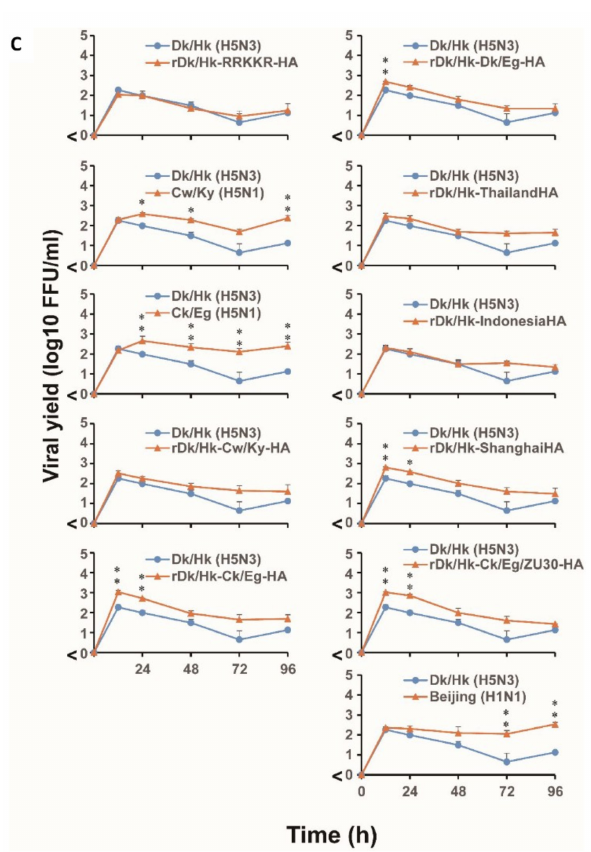
Figure 7. Growth kinetics of avian influenza viruses and their recombinant viruses in primary human tracheal epithelial cells and their established clones. ( A ) HTEpCs were infected with H5N1 (Cw / Ky (H5N1) and Ck / Eg (H5N1)), Dk / Hk (H5N3), rDk / Hk-RRKKR-HA, and recombinant H5N3 containing the HA gene from H5N1 viruses (as described in Figure 5) at an m.o.i. of 0.1 and incubated at 37 ◦ C. At the indicated times post-infection, the amount of progeny vRNA within the culture supernatants was determined by measuring virus titers in quantitative real-time PCR assays. ( B ) The infectious viral titers in infected cells were measured by infecting HTEpCs with AIVs and recombinant viruses, as described in ( A ). At the indicated times post-infection, the infectious titer of progeny virions in the culture supernatants was determined in a focus-forming assay. ( C ) The representative HTEpC-T clone LA-9 was infected with the AIVs described in ( A ) under the same infectious conditions. At the indicated times post-infection, the infectious titer of progeny virions in the culture supernatants was determined in a focus-forming assay. Data are expressed as the mean ± SD of three independent results. Asterisks indicate virus titers that are significantly higher than that of Dk / Hk (H5N3). A p -value < 0.05 (single asterisk) or < 0.01 (double asterisk) was considered significant (one-way ANOVA followed by Dunnett’s multiple comparisons post-hoc